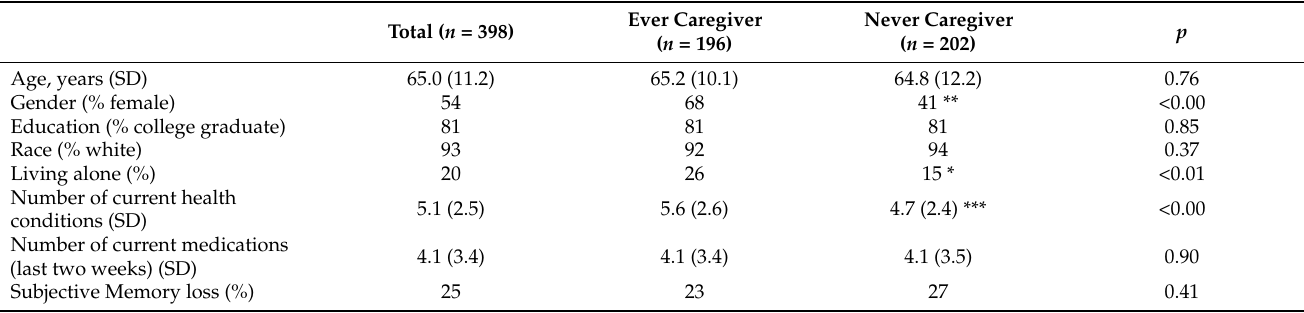
Table 2. Characteristics among those who have and who have not ever considered themselves an unpaid